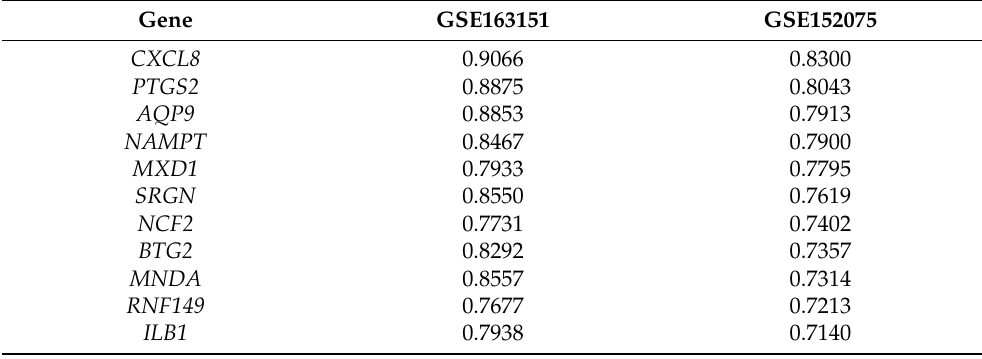
Table 1. List of genes with expression levels correlations with RGS2 in nasopharyngeal swabs from SARS-CoV-2 positive and negative individuals. Genes in GSE163151 and GSE152075 found with mRNA expression correlated with RGS2 expression (with R > 0.75 in at least of these GSE files) are listed by decreasing R values for GSE152075. All correlations had p < 2.2 × 10 − 16 . See Methods for further information.